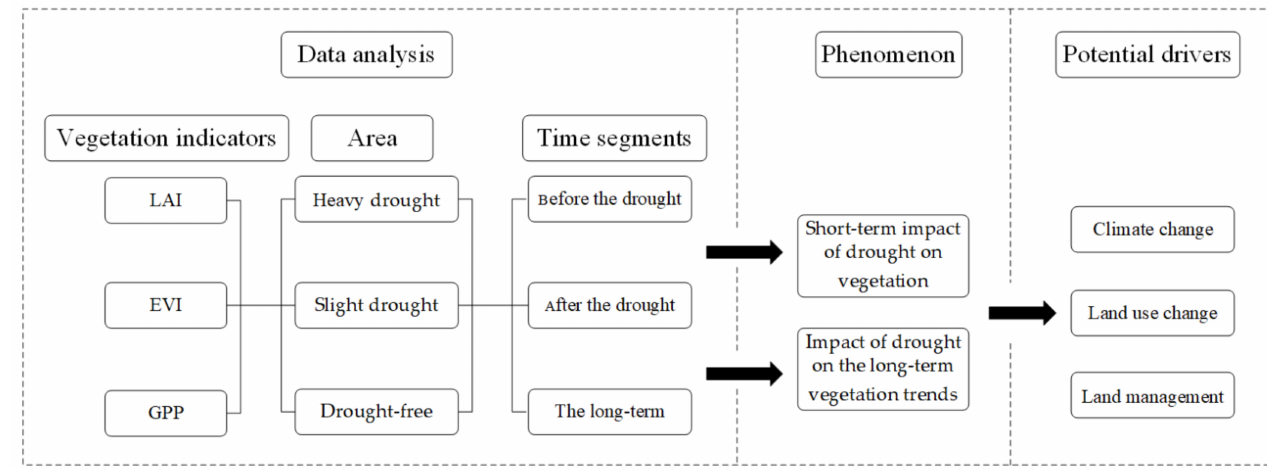
Figure 2. The flow chart of this